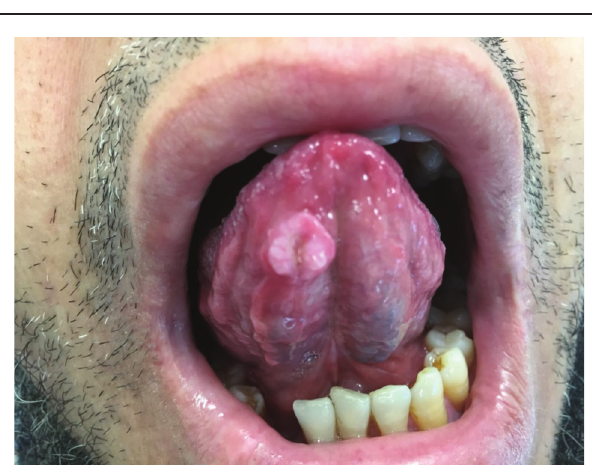
Ventral surface of the tongue mass